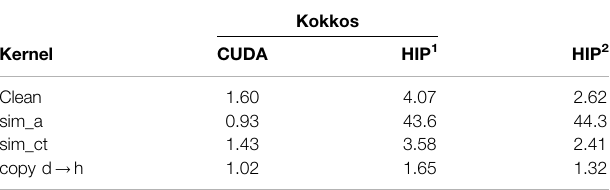
TABLE 5 | Relative kernel average execution times with CUDA and HIP 1 Kokkos backends, and a direct HIP 2 port, as a factor of the pure CUDA implementation execution time, as measured by GPU pro fi ling tools nvprof and